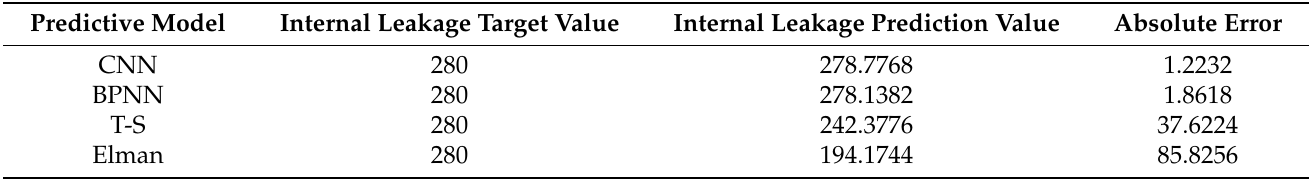
Table 1. Neural network prediction